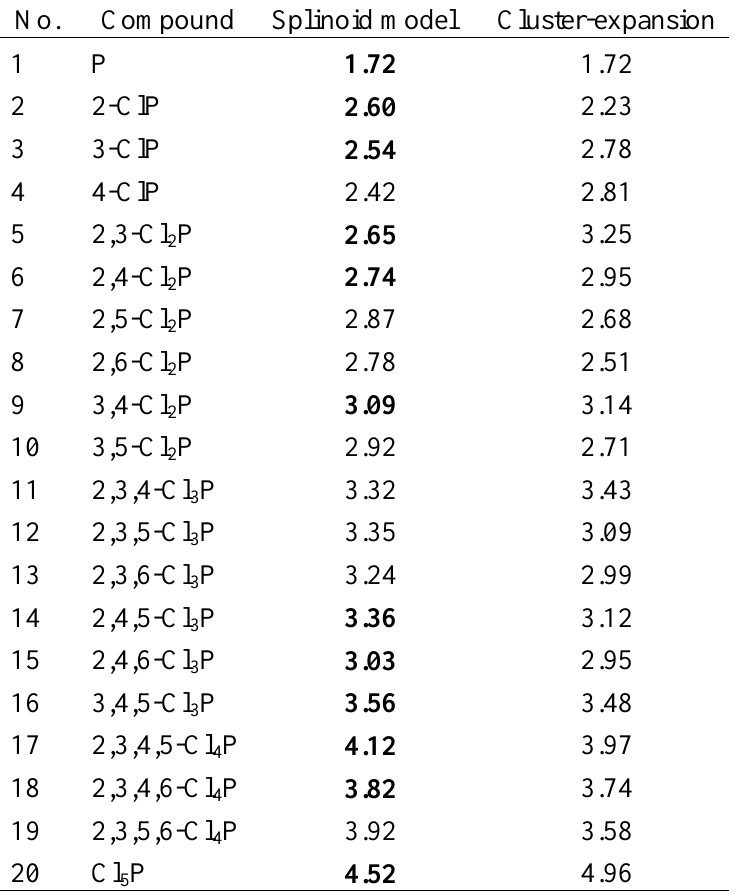
Table 1. Experimental and predicted values for cluster-expansion and splinoid QSSPR models for soil sorption coefficient, log K . The experimental values are presented in OC